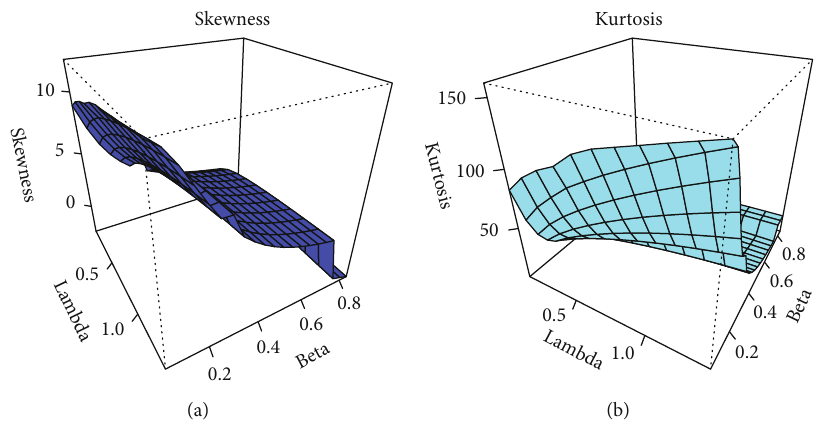
Figure 5: Graphical illustration of (a) skewness and (b) kurtosis of UPWD